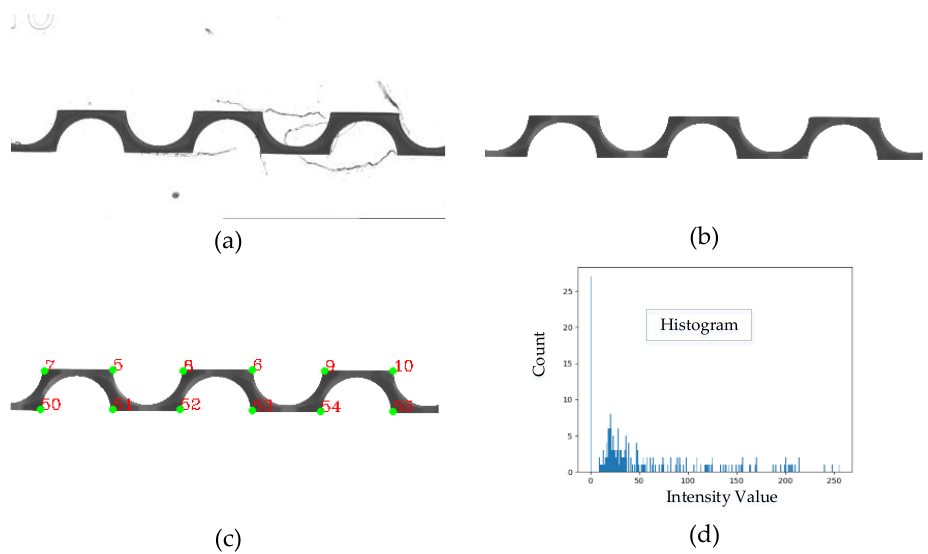
Figure 4. Steps of the image processing: ( a ) original image, ( b ) image without noise, ( c ) identification of corners, and ( d ) evaluation of color